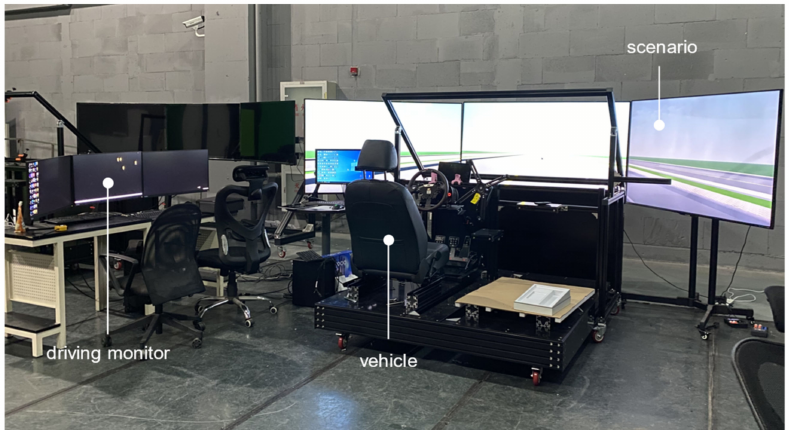
Figure 6. Experimental